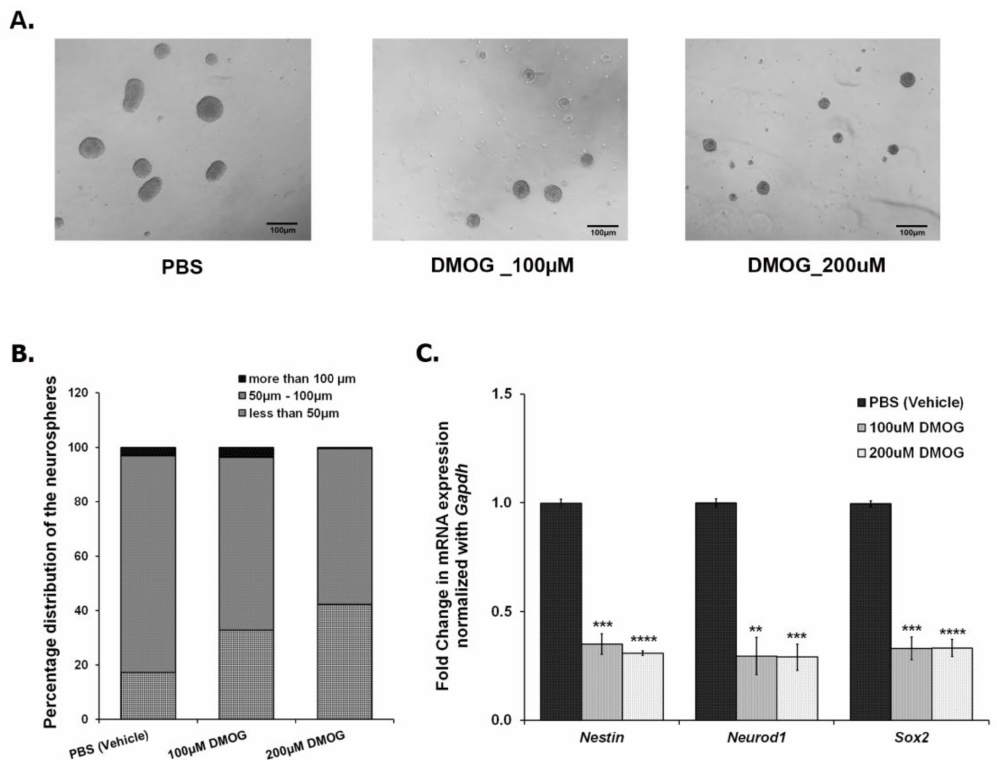
Figure 4. Treatment of NSCs / NPCs with DMOG, a pharmacologic inhibitor for JMJD2 family demethylases, resulted in a decrease in the proliferation of neurospheres ( A ) Representative images of the neurospheres treated with vehicle (PBS), 100 µ M DMOG, and 200 µ M DMOG. ( B ) Count of di ff erent sized neurospheres, taken after 6 days treatment with DMOG at di ff erent concentrations. ( C ) qPCR analysis shows a significant downregulation in the mRNA expression of Nestin , Neurod1 , and Sox2 in the DMOG treated samples as compared to the vehicle (PBS) treated ones. ** p < 0.01, *** p < 0.001, **** p <